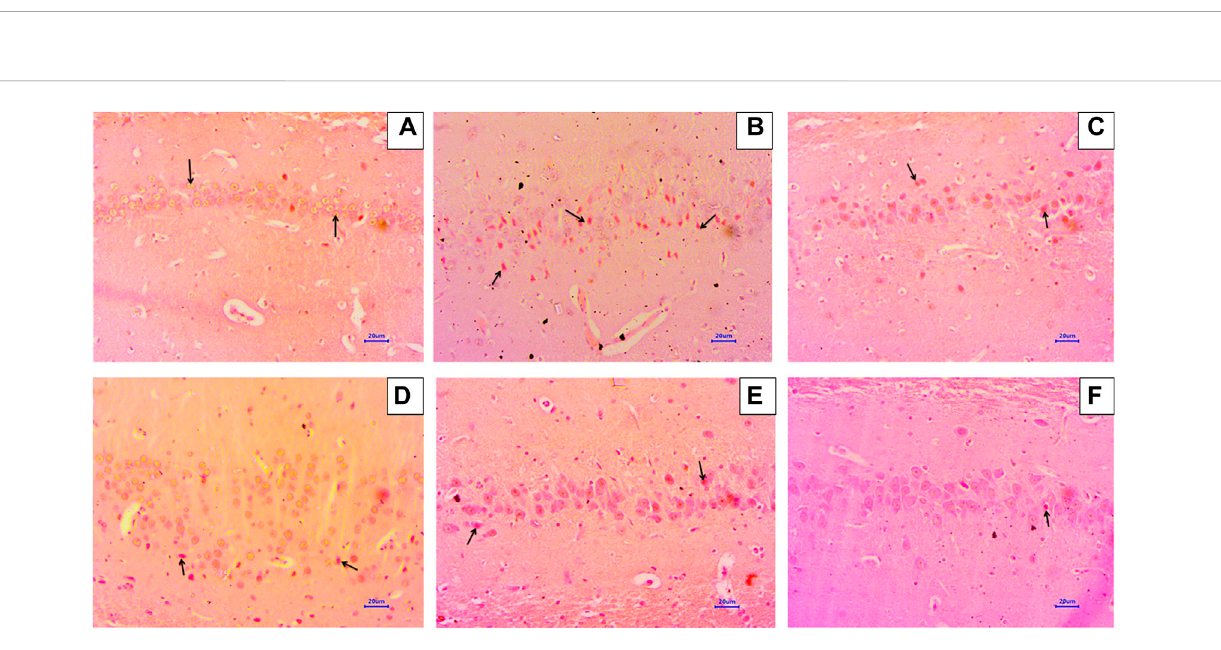
FIGURE 5 Effects of baicalein and baicalein with memantine on Congo red staining of the hippocampus tissue (400X), (A) Normal control: showing normal histology, normal neuronal cells in the hippocampus (small arrow), (B) Disease control: showing β -Amyloid deposition (small arrow) in the hippocampus, (C) Memantine (20 mg/kg): showing β -Amyloid deposition (small arrow) in the hippocampus, (D) Baicalein (10 mg/kg): showing β -Amyloid deposition (small arrow) inthehippocampus, (E) Memantine+ baicalein (20+5 mg/kg): showing β -Amyloiddeposition(smallarrow)inthehippocampus, (F) Memantine+ baicalein (20 + 10 mg/kg): showing β -Amyloid deposition (small arrow) in the